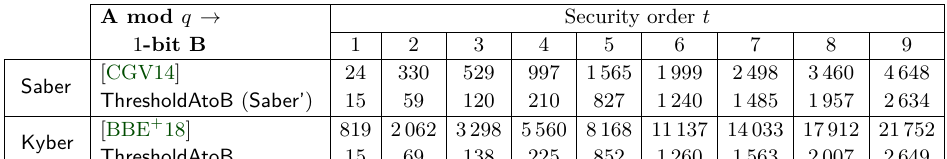
Table 15: Number of cycles to perform a threshold decryption including a conversion from arithmetic modulo q to 1-bit Boolean, for Kyber (with q = 3329) and Saber (with q = 2 10 ). For our TresholdAtoB algorithm (Algorithm 13), this is according to the values of ‘ from Table 8.